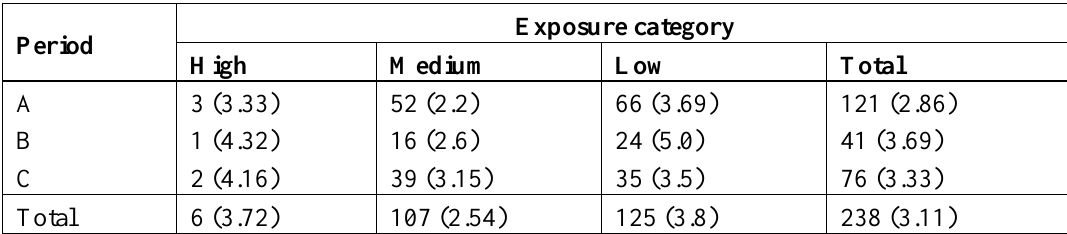
Table 2. Number of infant leukemia cases (rates per 100,000 births in the period) in UK by exposure category (from CCRG).